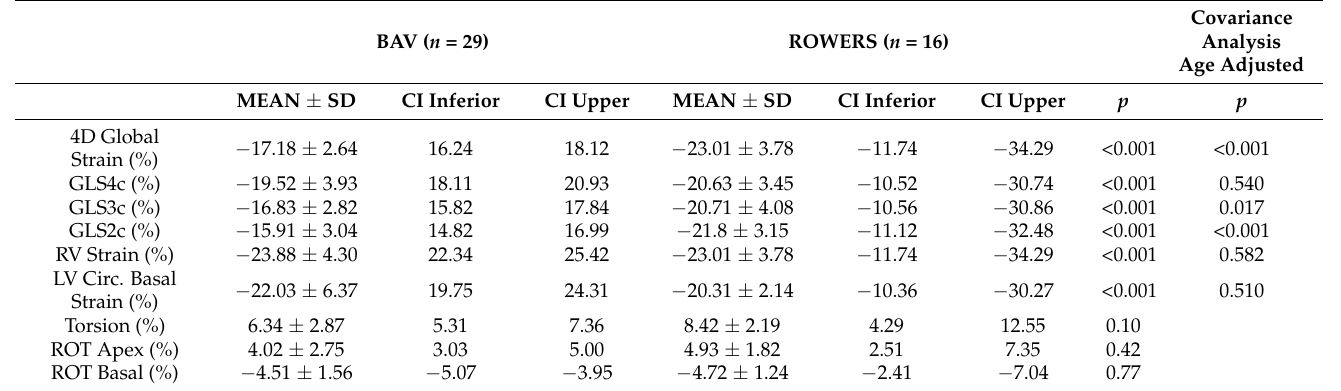
Table 3. Strain parameters of the